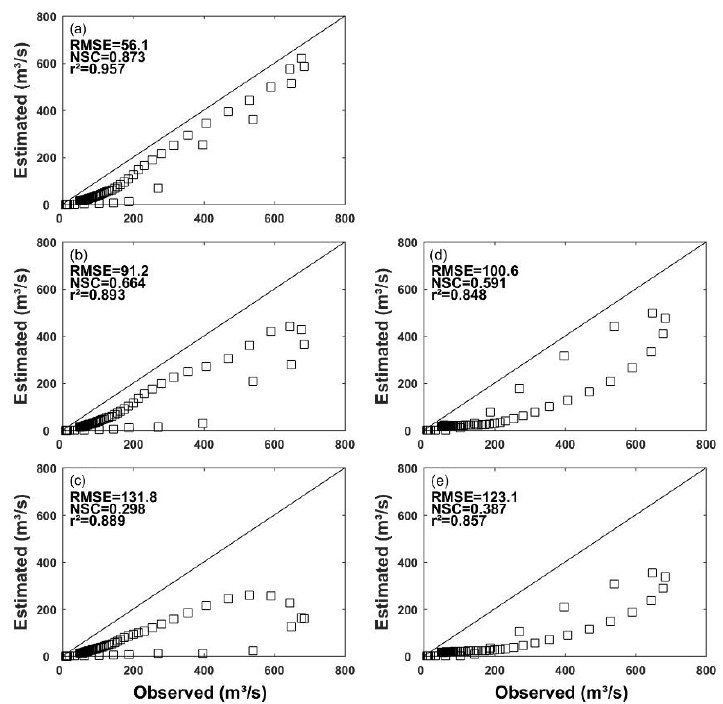
Figure 6. Observations versus simulations using the Green-Ampt: ( a ) mosaic/FLO-2D, ( b ) arithmetic/FLO-2D, ( c ) predominant/FLO-2D, ( d ) arithmetic/HEC-HMS, and ( e ) predominant/HEC- HMS.